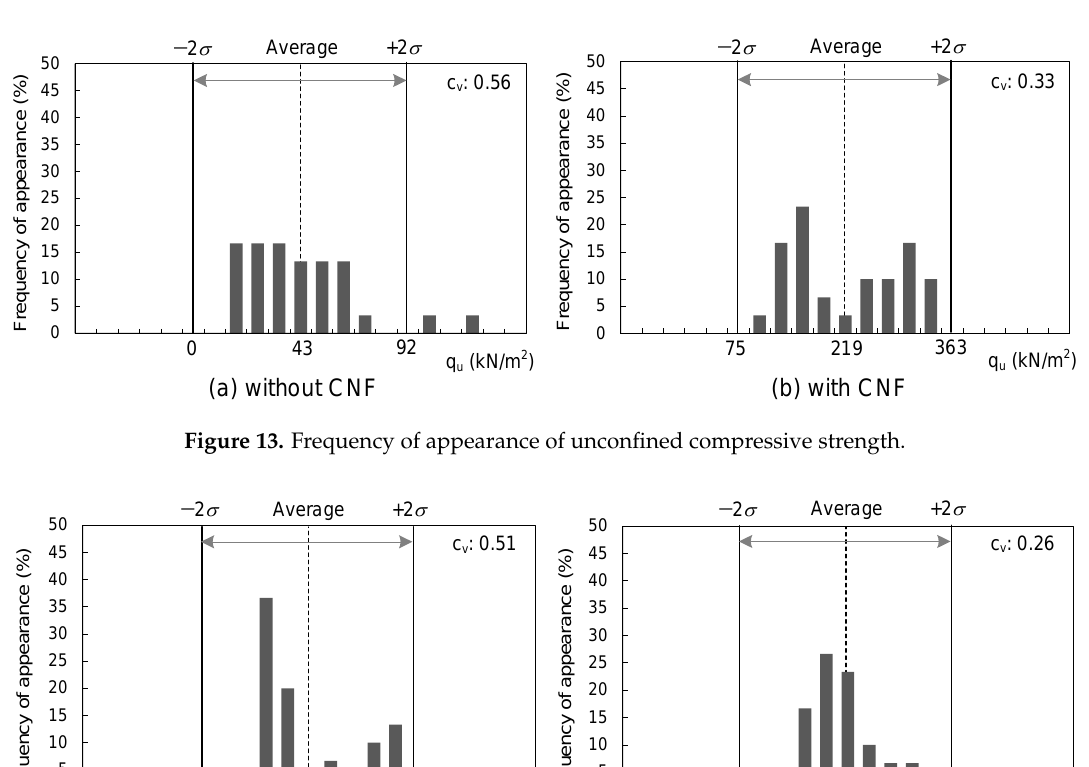
Figure 13. Frequency of appearance of unconfined compressive strength.